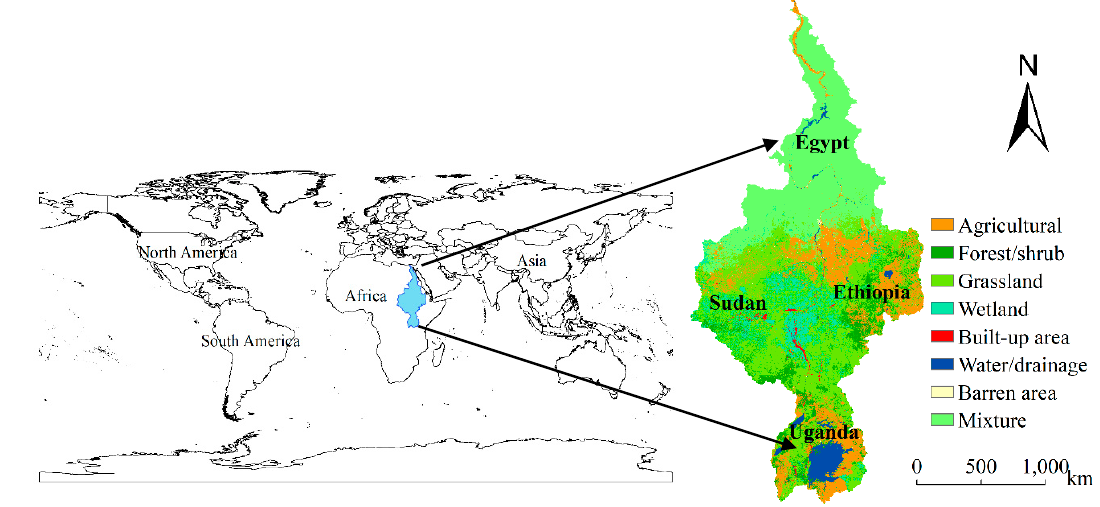
Figure 1. Location and land use map of the study area.